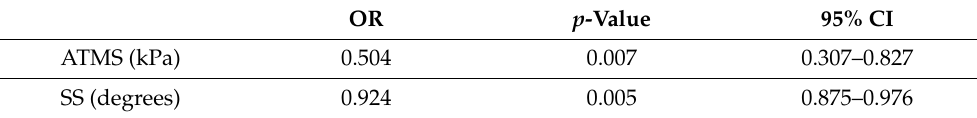
Table 2. Multiple logistic regression analysis of factors associated with progressive spinal sagittal